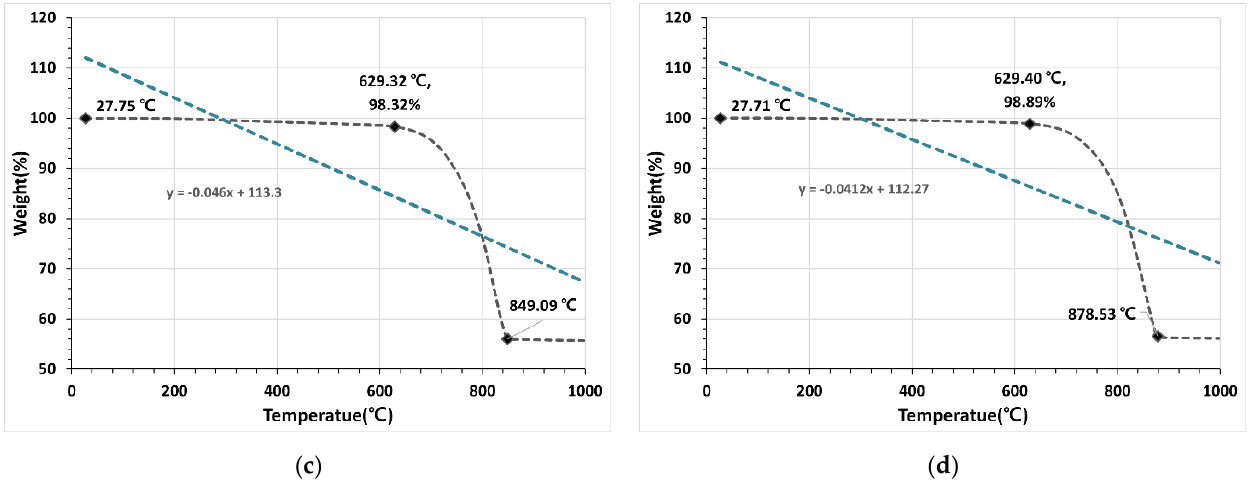
Figure 9. TGA measurement results: ( a ) TGA of OSA0.6U; ( b ) TGA of OSA0.6; ( c ) TGA of OSA1.2; ( d ) TGA of OSA2.5.